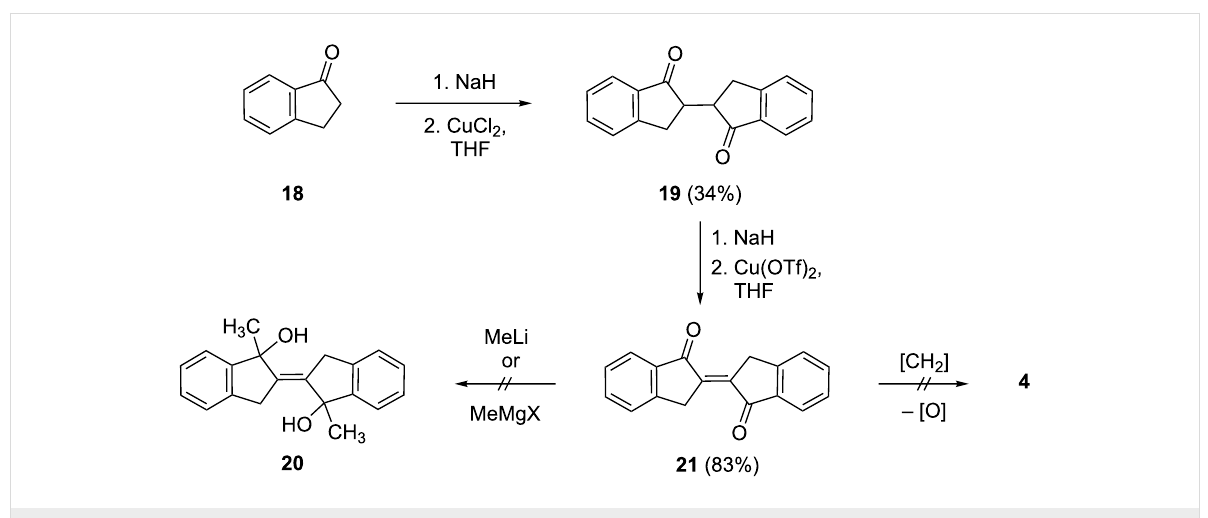
Scheme 4: Dimerization of indan-1-one ( 18 ) by a stepwise